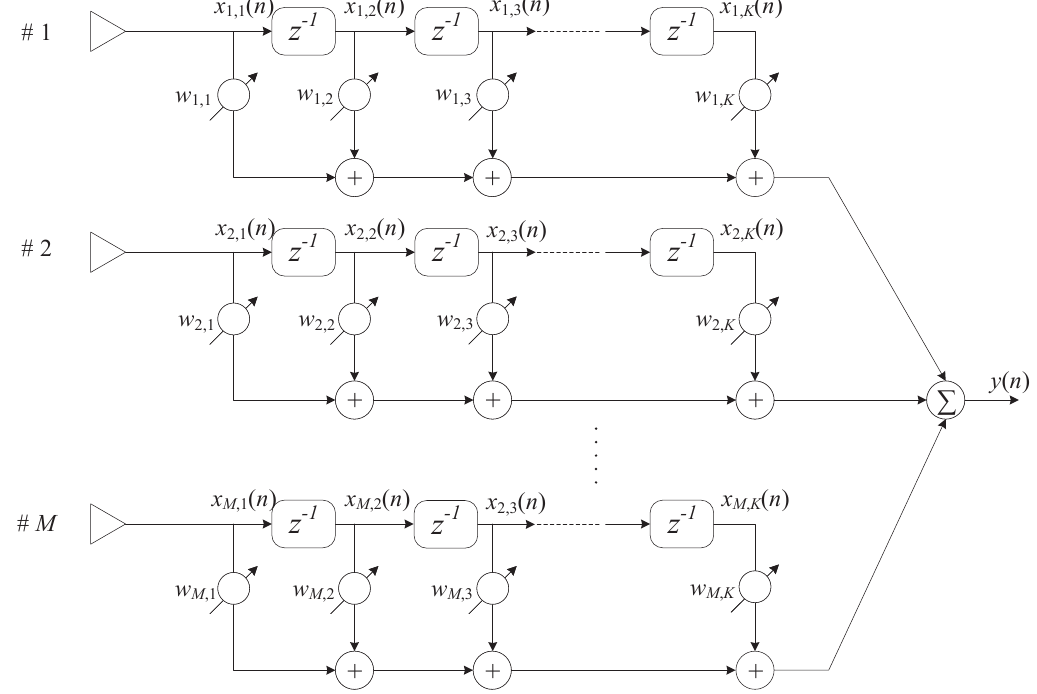
Figure 1. Adaptive time − domain beamforming structure without delay